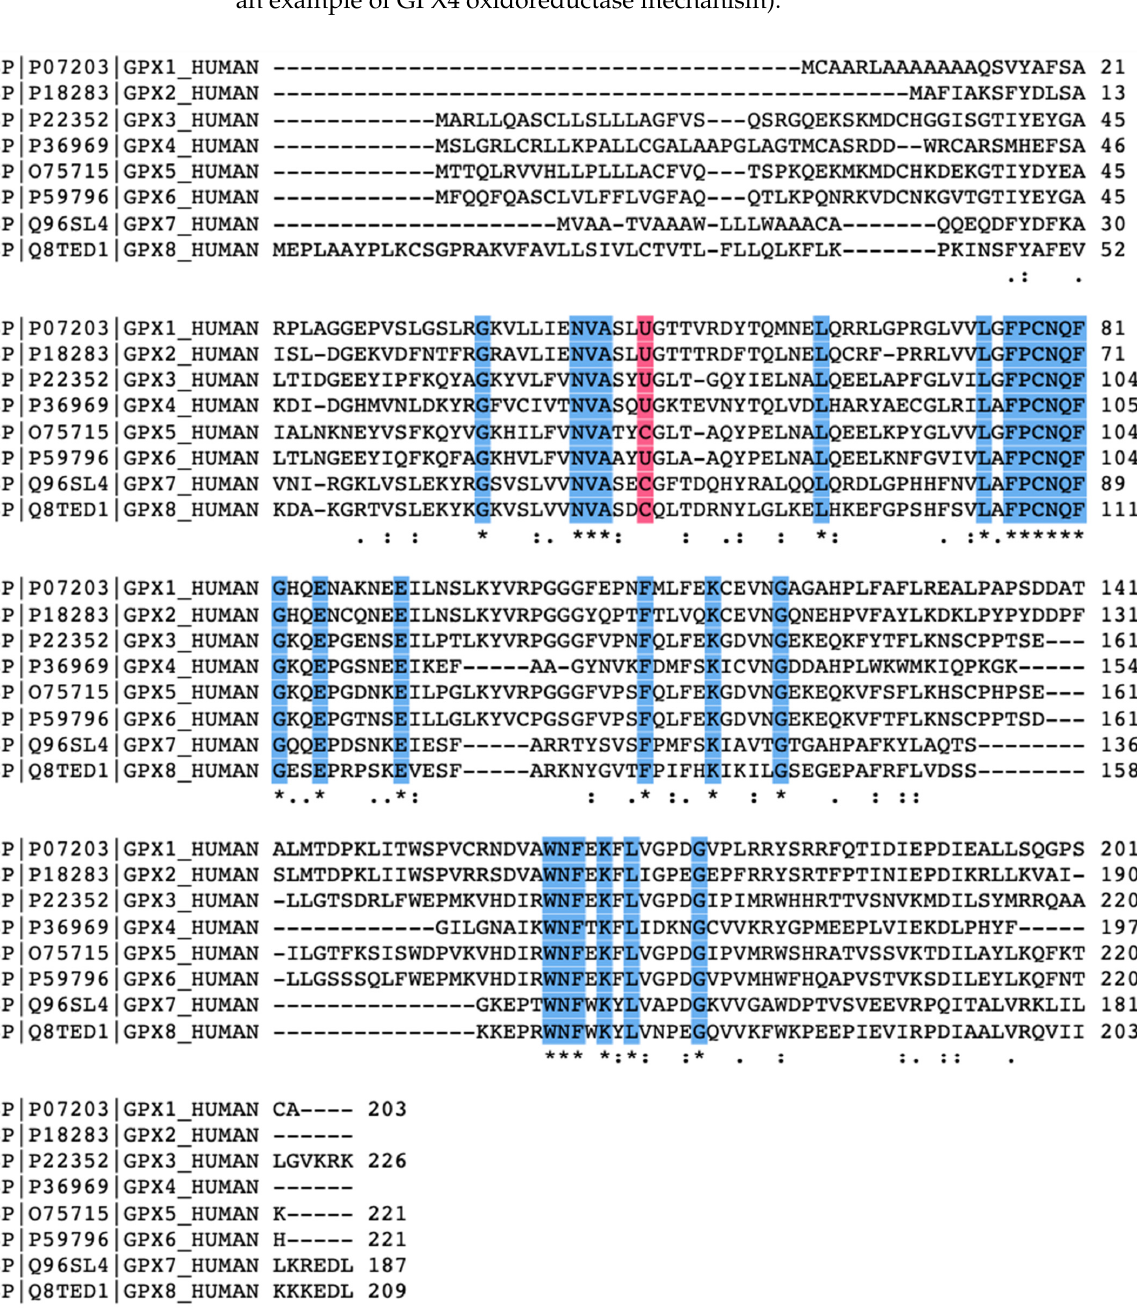
Figure 2. Amino acid sequence alignment adapted from Uniprot comparing human GPX1-through- GPX8. Blue highlighted regions fully conserved residues. The glutathione peroxidase family has overall low sequence similarity. The pink highlight recognizes the redox-active site (U: Selenocys- teine; C: Cysteine). Symbols: An asterisk represents fully conserved residues. A colon represents conservation of residues with very similar chemical properties. A period represents conservation of resides with weakly similar properties.